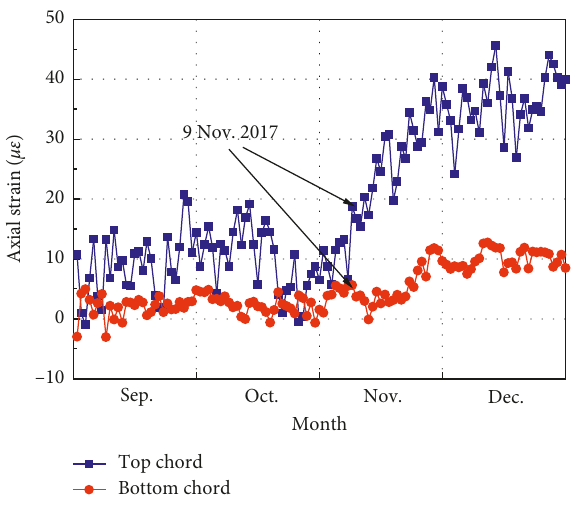
Figure 34: Axial strain